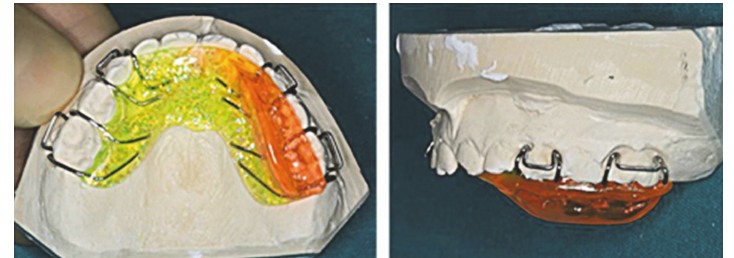
Figure 3: Functional removable appliance.